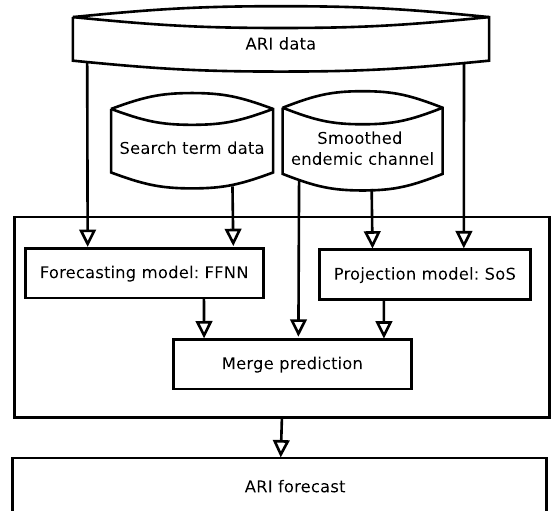
Figure 3. The Computational model, which receives the ARI data, the search terms data and the smoothed endemic channel data as inputs, and is composed by a Forecasting model working in parallel with a Projection model to feed the third module of this stage, the Merge